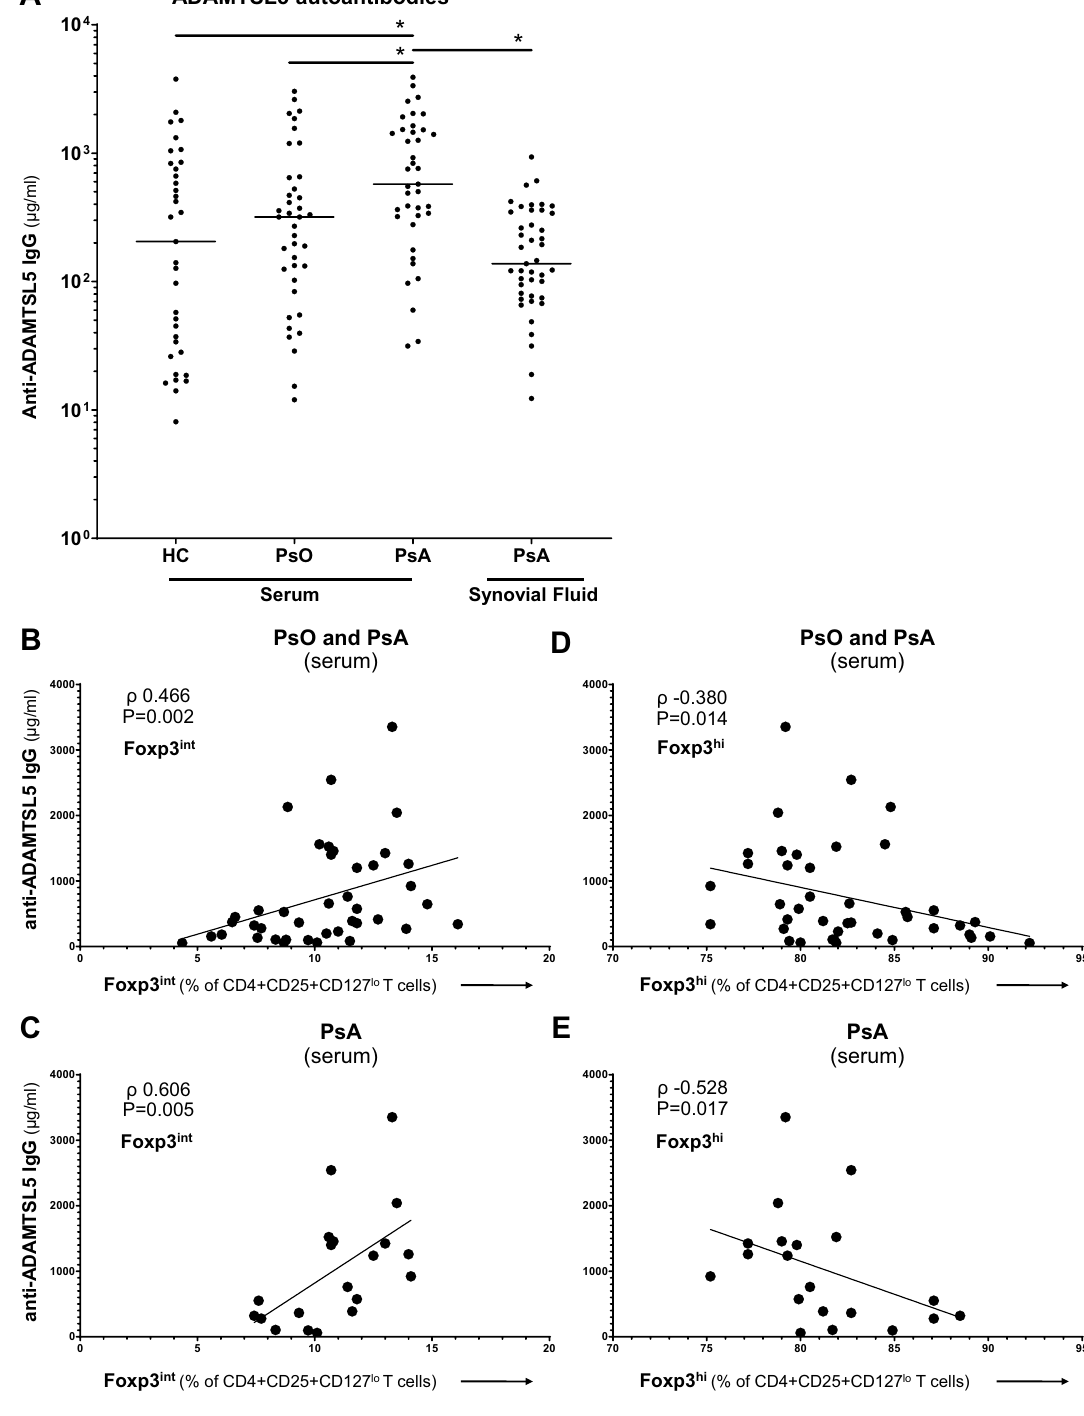
Figure 6. Foxp3 downregulation by Tregs associates with ADAMTSL5 autoantibodies in psoriatic disease. Association of ADAMTSL5 autoantibodies as measured by ELISA with Foxp3 expression by Tregs as measured by flow cytometry. ( A ) ELISA of anti-ADAMTSL5 IgG in sera of HC (n = 35), psoriasis patients (n = 39), PsA patients (n = 39), and synovial fluid of PsA patients (n = 43). * P value < 0.05. ( B – E ) Scatterplots of significant Spearman’s rank correlation of serum anti-ADAMTSL5 autoantibody concentration with Foxp3 expression by CD3 + CD4 + CD25 + CD127 lo T cells derived from peripheral blood of psoriasis (n = 21) and PsA patients (n = 20). Differentiation between Foxp3 int ( B , C ) and Foxp3 hi ( D , E ) Tregs in patients with psoriatic disease ( B , D ) versus PsA patients only ( C , E ). ADAMTSL5: A Disintegrin And Metalloprotease domain containing ThromboSpondin type 1 motif-Like 5; Foxp3 int / -hi : forkhead box P3 expression intermediate / high; HC: healthy control; IgG: Immunoglobulin G; P: p value; PsA: psoriatic arthritis; PsA: psoriatic arthritis; PsO: psoriasis; ρ: Spearman’s